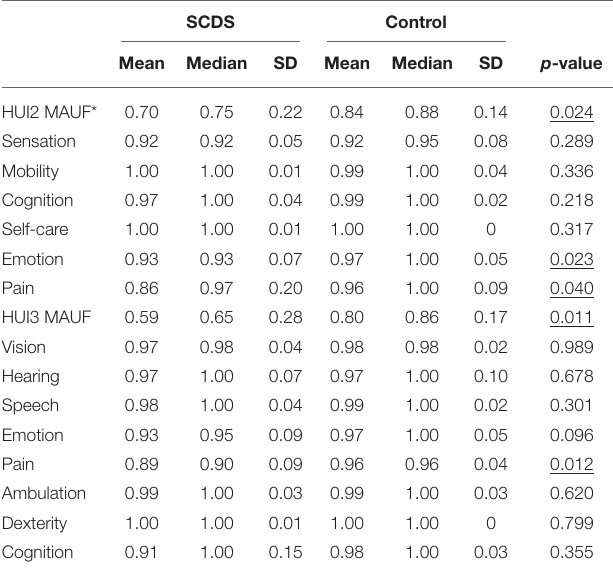
TABLE 1 | Single and multi-attribute scores of study